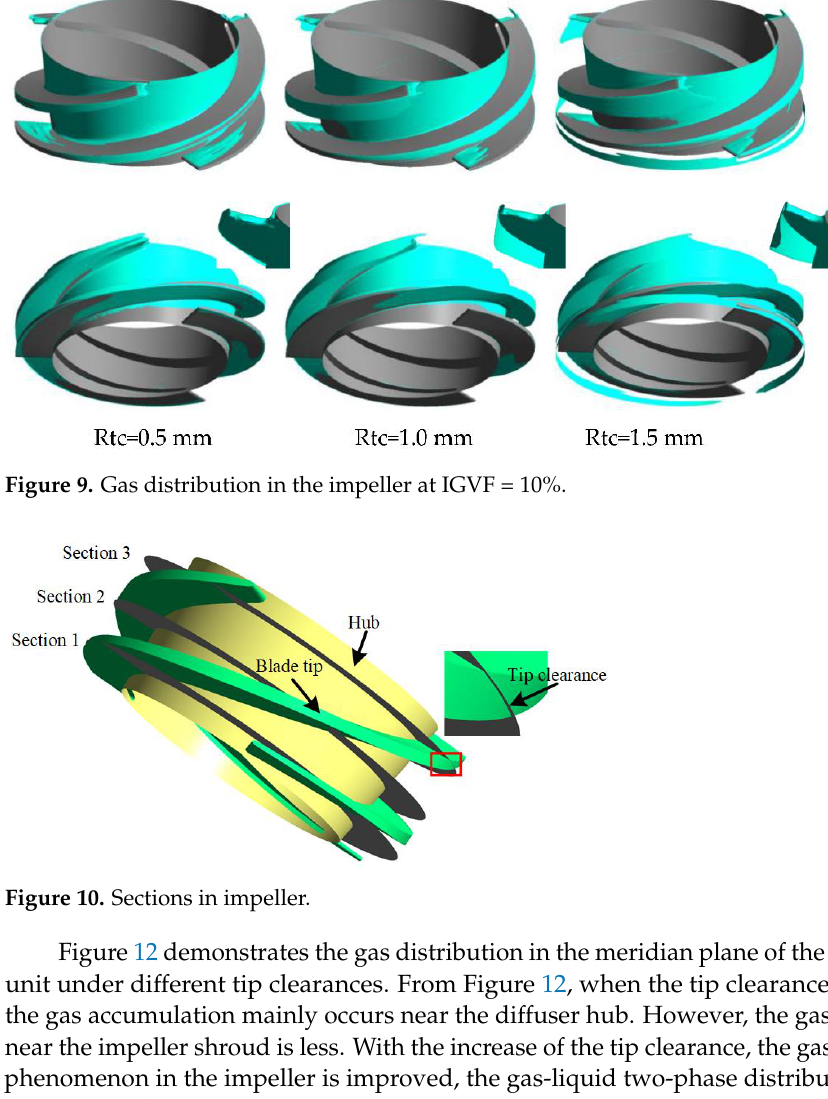
Figure 11. Gas distribution on different sections. Figure 12 demonstrates the gas distribution in the meridian plane of the pressuriza- tion unit under different tip clearances. From Figure 12, when the tip clearance Rtc = 0.5 mm, the gas accumulation mainly occurs near the diffuser hub. However, the gas accu- mulation near the impeller shroud is less. With the increase of the tip clearance, the gas accumulation phenomenon in the impeller is improved, the gas-liquid two-phase distri- bution gradually becomes uniform, and the gas-liquid two-phase distribution in the dif- fuser is also improved, especially at the hub near the rotor stator interface. In general, the tip clearance size has a greater effect on the gas-liquid two-phase distribution in the mul- tiphase pump. The larger the tip clearance is, the more uniform the gas-liquid distribution in the multiphase pump becomes. However, an excessively large tip clearance increases hydraulic loss. Therefore, it is necessary to weigh the phase distribution and hydraulic loss to determine the optimal tip clearance.